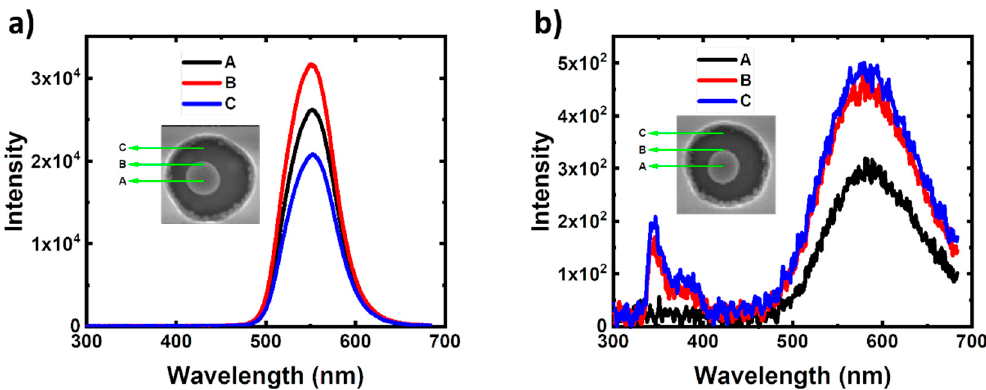
Figure 2. CL spectra measured at Points A, B, and C for ( a ) the Ag–PhC / QW sample and ( b ) Ag–PhC / woQW sample. Their insets show the measurement points in the SEM images.